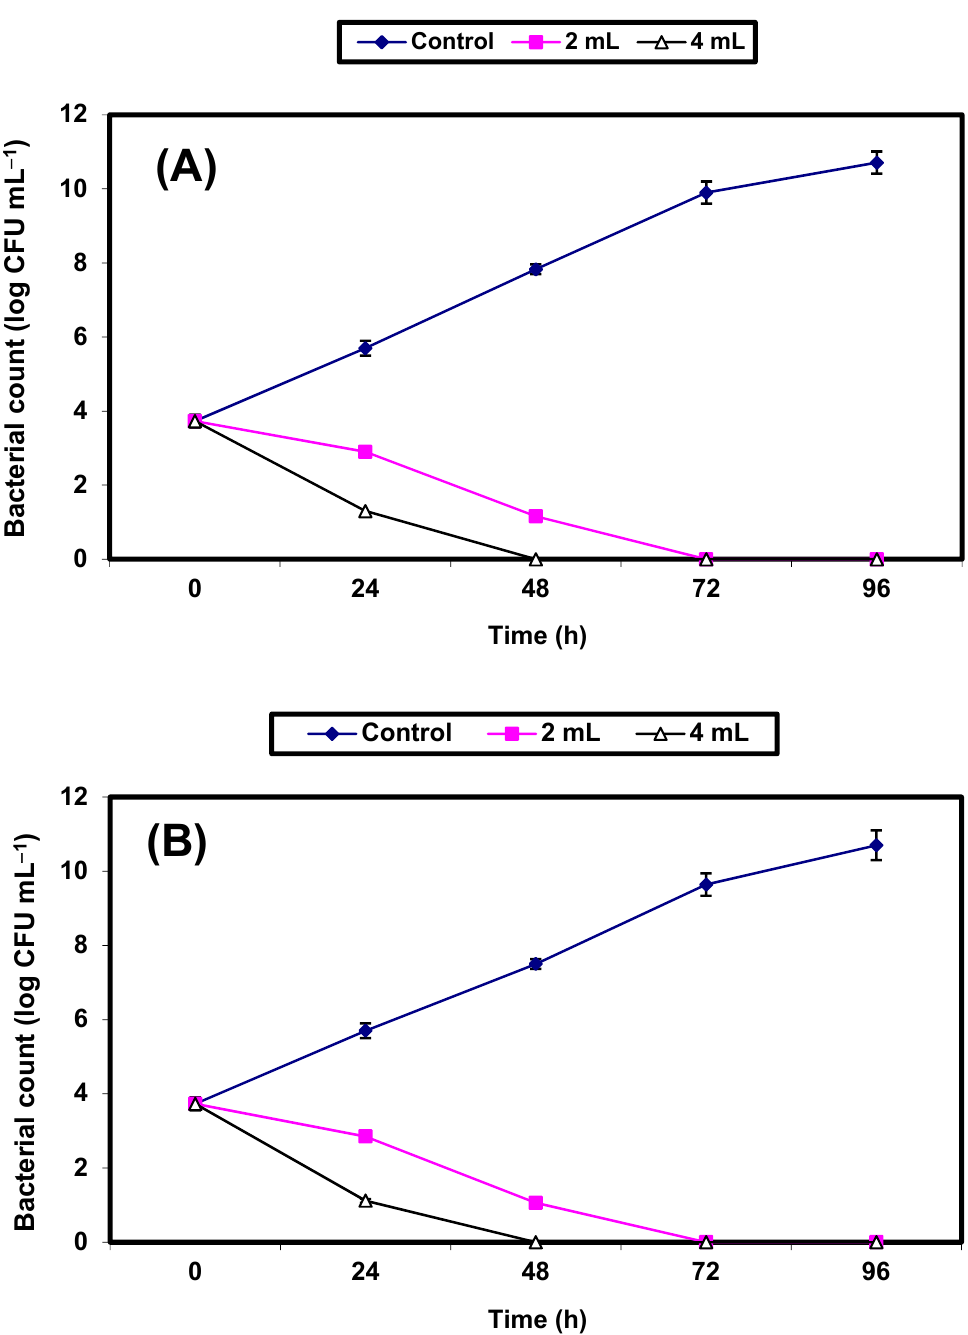
Figure 6. Inhibition of both S. aureus ( A ) and E. coli ( B ) in strawberry juice. Symbols ♦ , ■ , ∆ refer to untreated control samples and juice samples treated with 2% and 4% KFB, respectively.